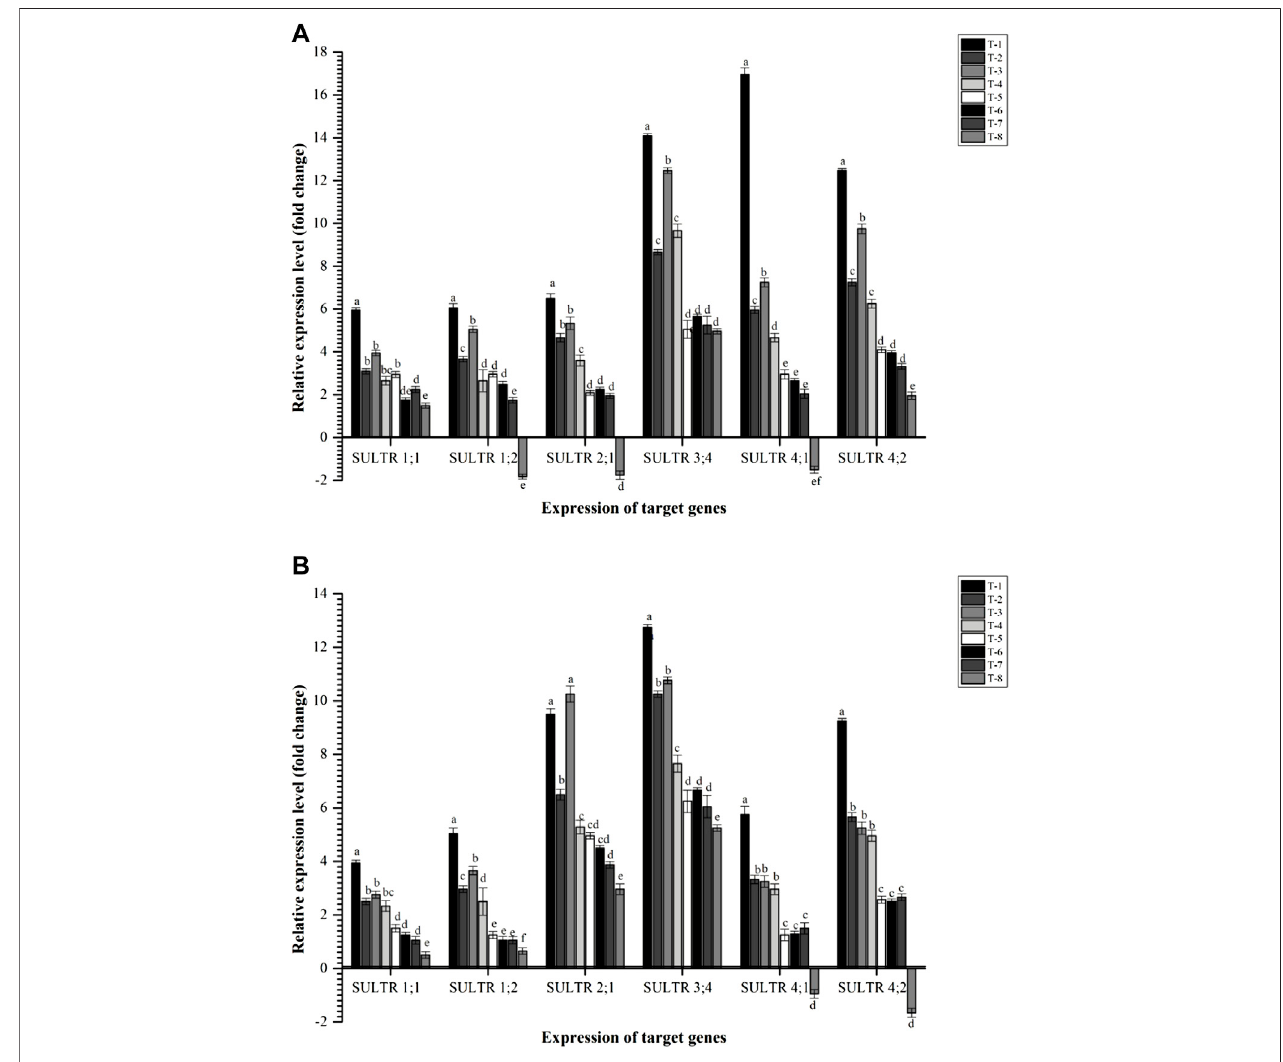
FIGURE10| Effects ofseedinoculation ofSOBonexpression ofsulfurtransportersin thepigeonpealeaves at (A) 30and (B) 60 days ofsowing.Treatmentswere as follows: T1 — Stenotrophomonas maltophilia DRC-18-7A, T2 — S. maltophilia DRC-18-10, T3 — S. pavanii DRC-18-7B, T4 — S. pavanii DRC-18-11, T5 — R. pusense DRC-18-25,T6 — R.pusense DSC-18-5,T7 — R.pusense DJC-18-21,andT8 — Untreatedcontrol(Noinoculation).Dataaremean( n =5)andverticalbarrepresentsthe standarddeviation.Datawithdifferentlettersshowsigni fi cantdifferenceincolumndatainrandomizedblockdesigntestat p < 0.05underDuncan ’ smultiple-range